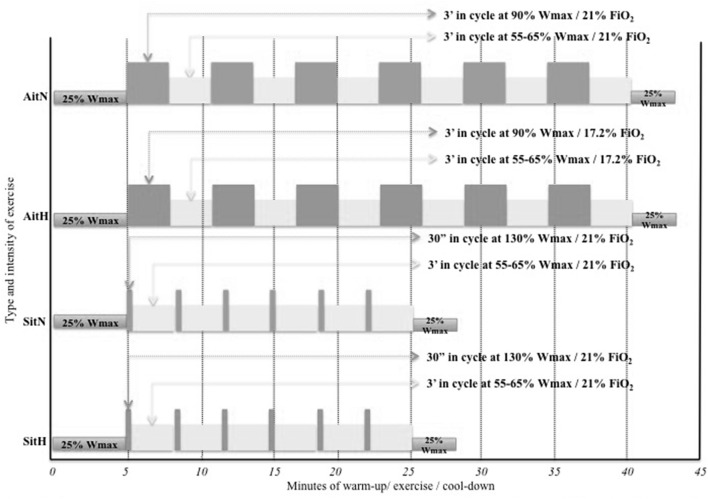
Schematic representation of the four exercise prescriptions allocated at randomisation. AitH: Aerobic interval training Hypoxia group; AitN: Aerobic interval training Normoxia group; SitH: Sprint interval training Hypoxia group; SitN: Sprint interval training Normoxia group; Wmax: maximal work-load; FiO2: inspired fraction of oxygen.